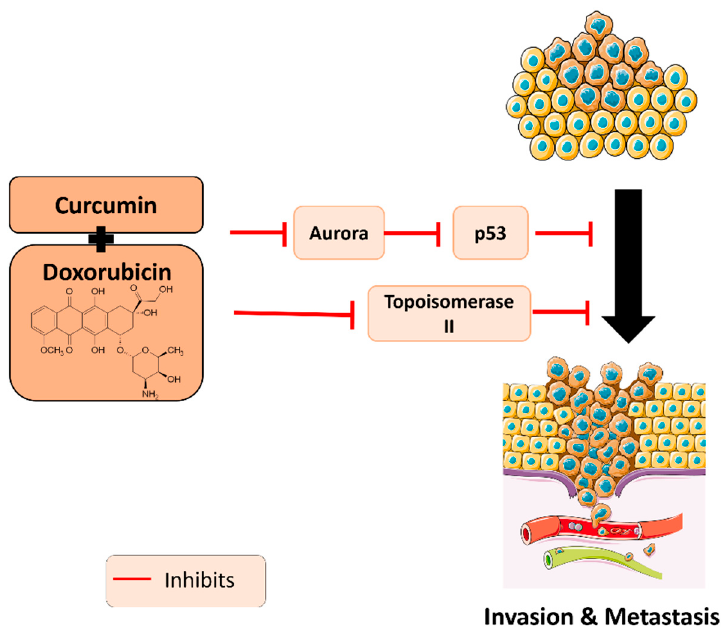
Figure 3. Molecular pathways underlying the anti-metastatic and anti-invasive properties of curcumin in combination with doxorubicin.